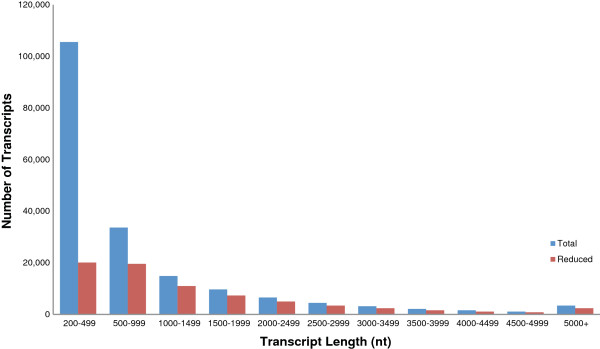
Length distribution of assembled transcripts for total and reduced datasets. The sizes of the Trinity assembled transcripts are shown. The reduced set has an FPKM >0.5.